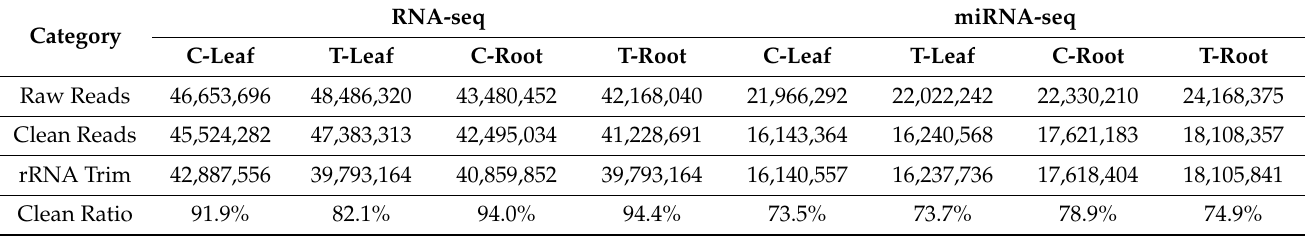
Table 1. Statistical analysis of sequencing reads from RNA-seq and miRNA-seq libraries of Brassica juncea L. leaves and roots.